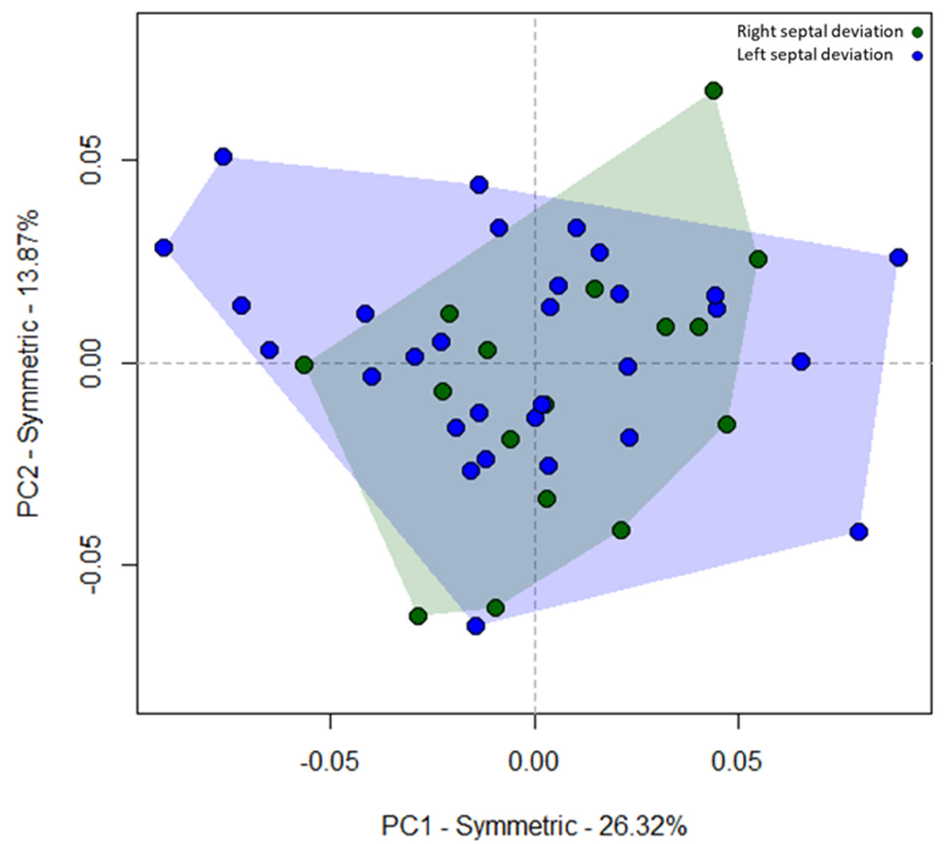
Figure 6. PCA of the symmetric component of the facial complex. Colours indicate whether an individual was characterised by left (blue) or right (green) nasal septal deviation. PC1 explains 26.32% of the total variance, while PC2 explains 13.87% of the total variance. Sample size: 46 specimens.